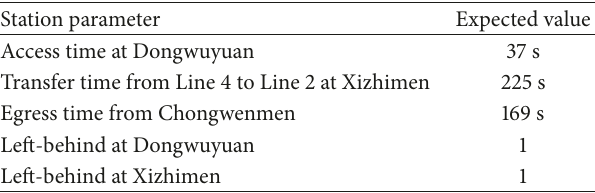
the distribution of relatively congested sections during peak hours is similar. The relatively congested sections mainly focus on the out-of-Beijing direction and are located around Central Business Districts (CBD) during off-peak and